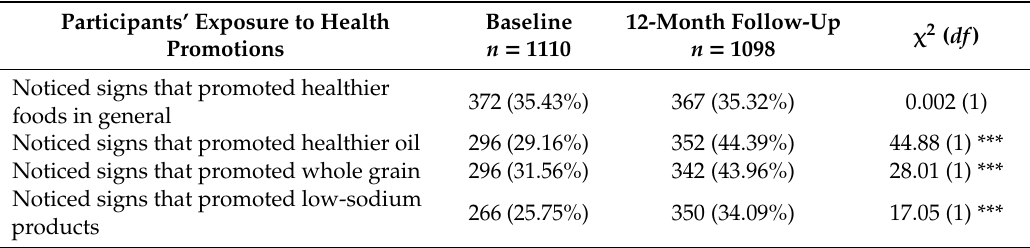
Table 4. Exposures to Health Promotions.